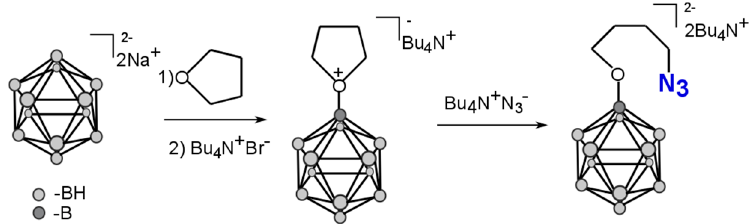
Figure 1. Scheme of the synthesis of the bis-tetrabutylammonium-(4-azidobuthoxy)-undecahydro- closo -dodecaborate (azido derivative of closo -dodecaborate).